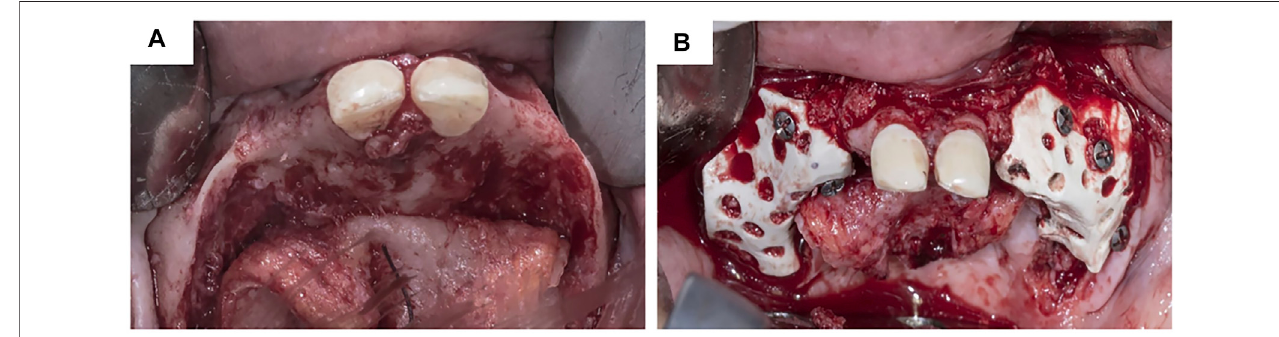
FIGURE 6 | Customized PEEK mesh in clinical usage. (A) Customized PEEK mesh. (B) Fixation of customized PEEK mesh. Reproduced with permission from El Morsy et al.